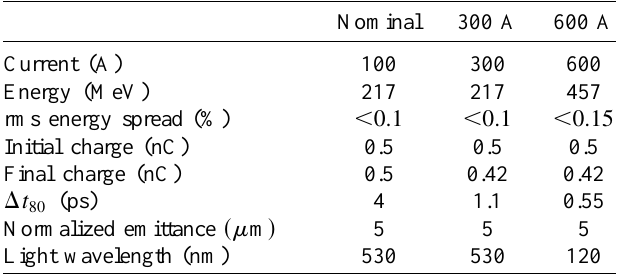
TABLE II. Desired Low-Energy Undulator Test Line (LEUTL) operating points.